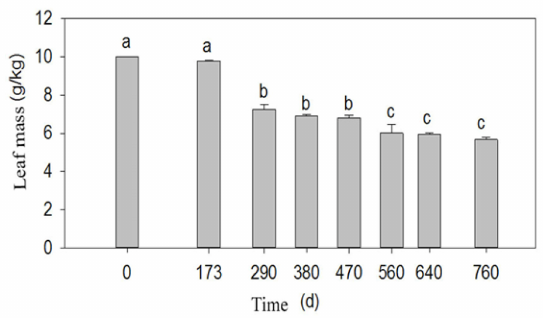
Figure 2. Leaf mass change during decomposition. Within graph, histograms with the same letter indicate that the value was not significantly different ( p < 0.05). Values are means +SE.